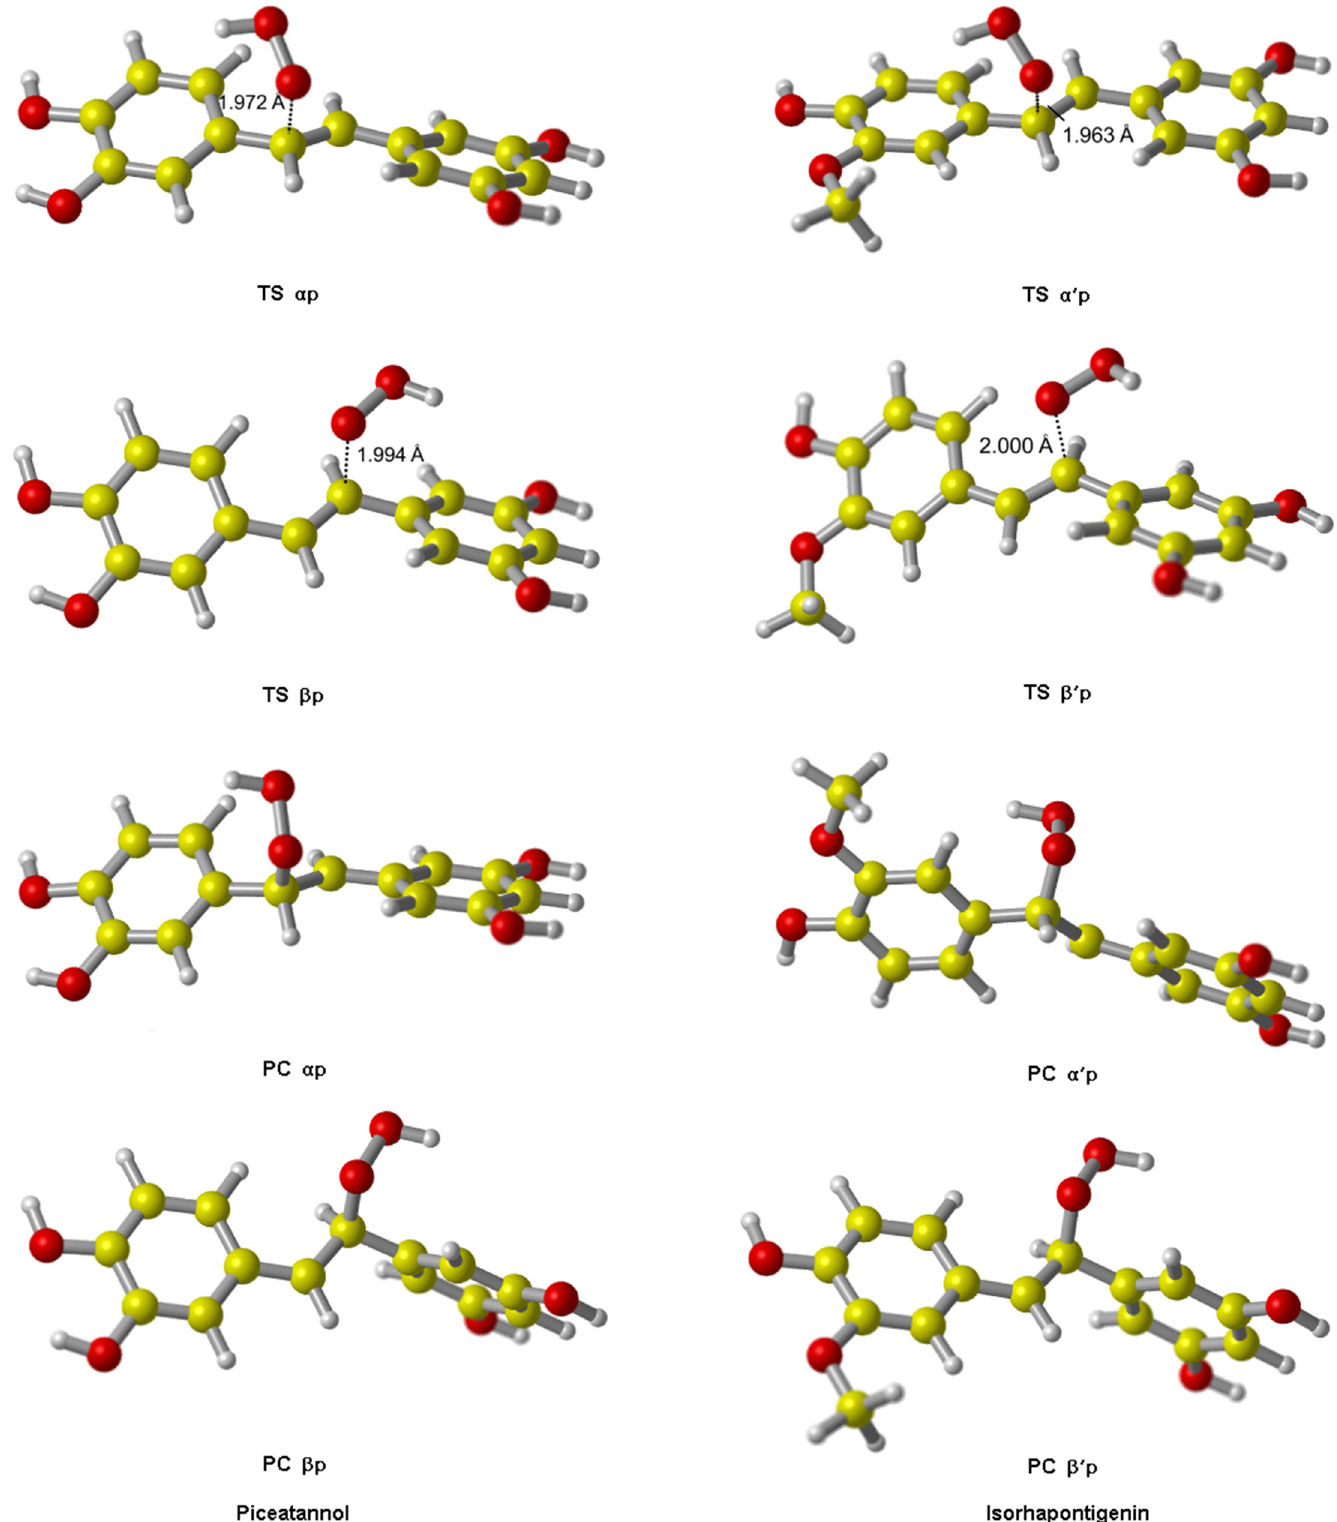
Fig 8. The transition states and product complexes of PIC and ISO from RAF reaction initiated by (cid:129) OOH. All TS have only one imaginary frequency, and in their vibrational mode, (cid:129) OOH moves in a direction which is perpendicular to that of the carbon atom. The H atom attached to that carbon atom folds back slightly to accommodate the incoming of (cid:129)